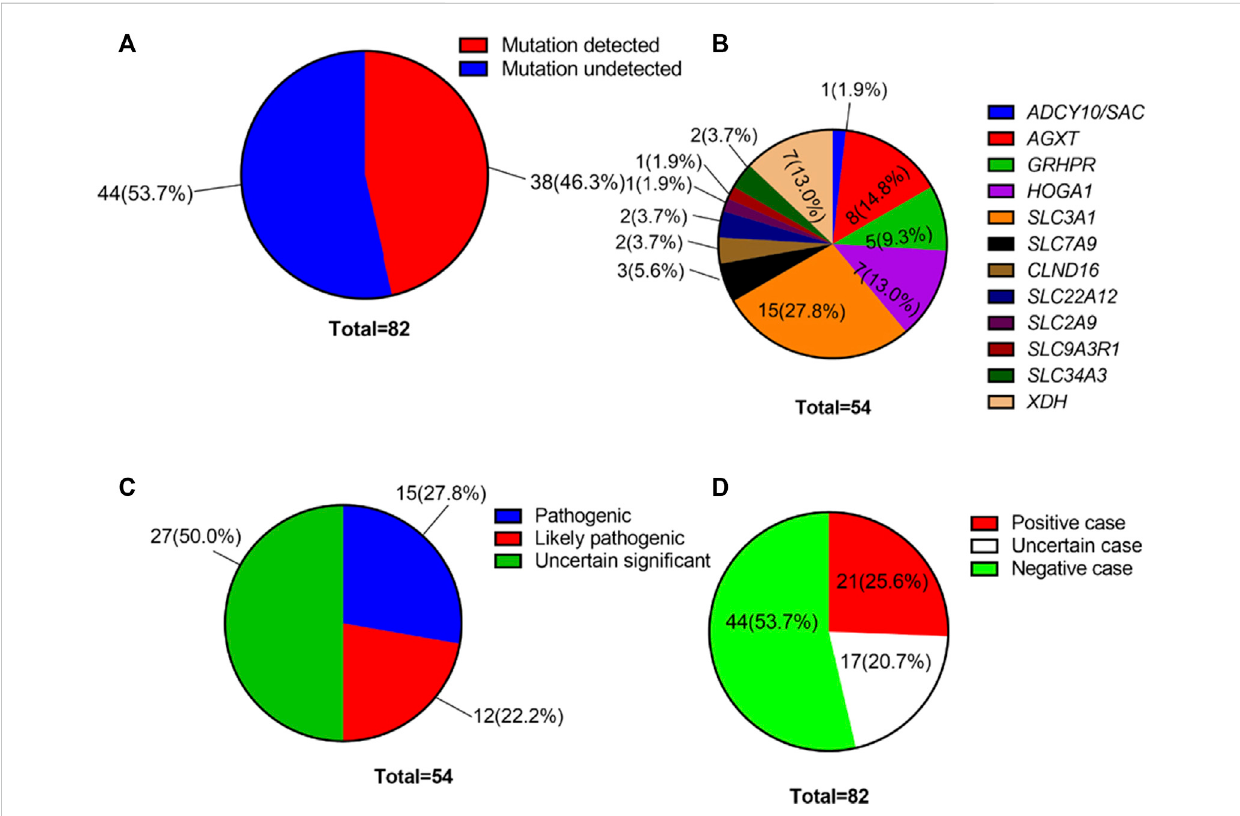
were heterozygous, and only seven (10.9%) were homozygous (Figure 2A). In addition, uniparental disomy of chromosome 2 was identi fi ed in patient P26, who was homozygous for the c.1320G > T (p.Trp440Cys) mutation in SLC3A1 and c.2006G > C (p.Gly669Ala) in XDH . The proband ’ s father was heterozygous for mutations that were absent in the mother ’ s DNA. In addition, 48 mutations were inherited in an autosomal recessive (AR) mode of inheritance, two mutations were autosomal dominant (AD), and the combined dual inherited mode of AD/AR was identi fi ed in four mutations (Figure 2B). Groups of age < 1 year old (50%, 8/16) and 6 – 15 years old (63.6%, 14/22) exhibited most genetic variants (Supplementary Figure S1A). Variants in dominant genes ADCY10 and SLC9A3R1 were mainly identi fi